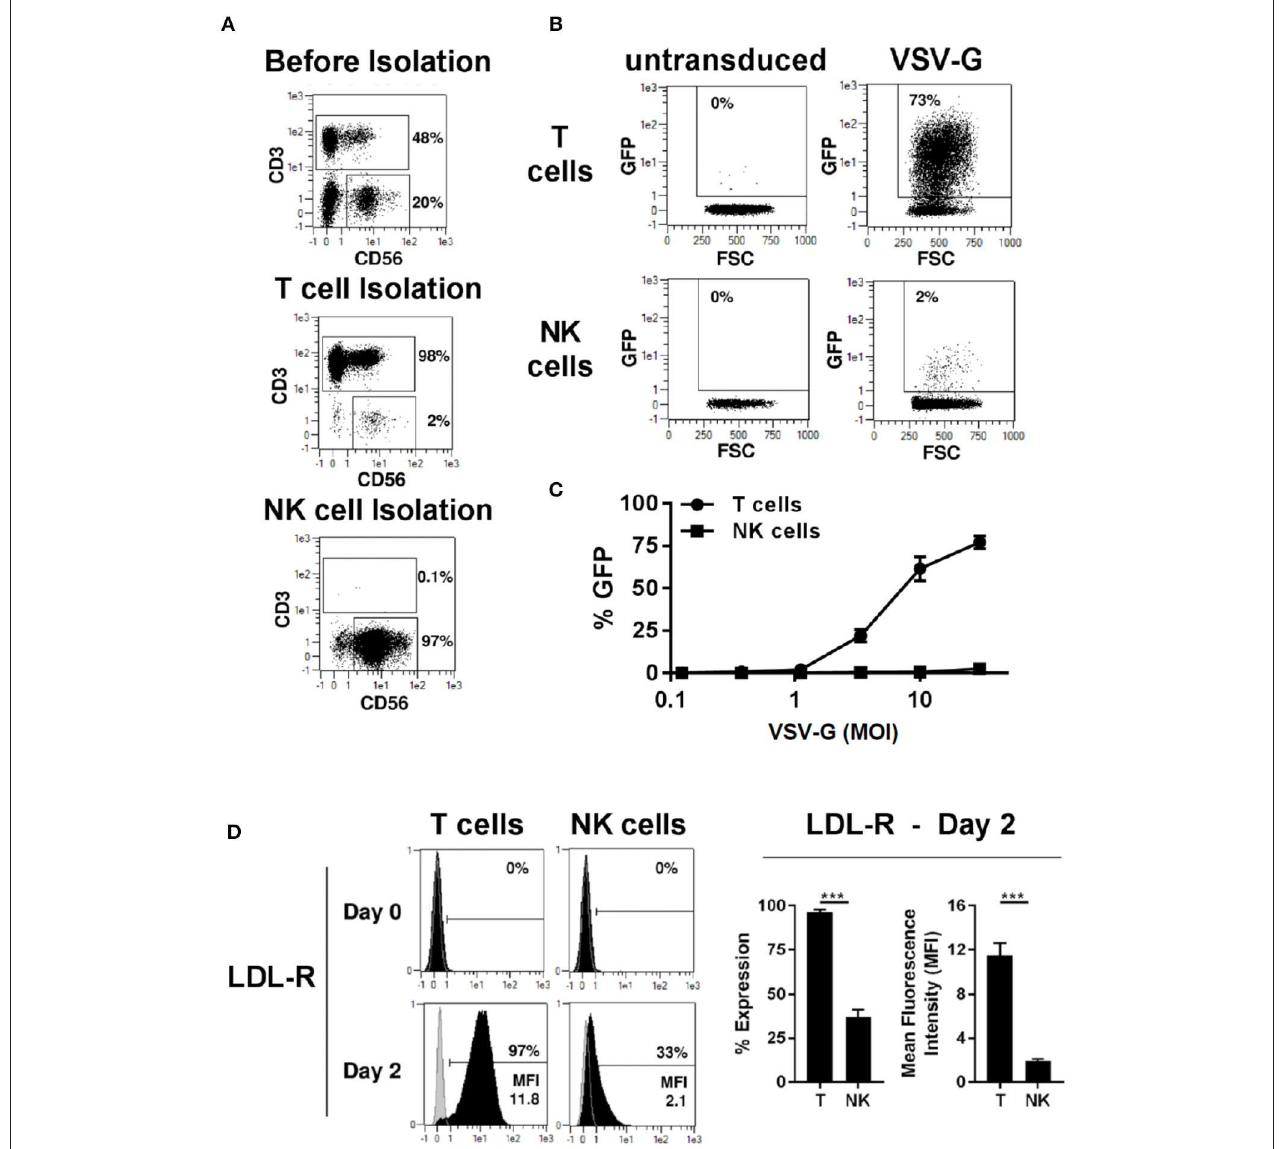
FIGURE 1 | VSV-G pseudotyped LV efficiently transduces T cells but not NK cells. Magnetic separation was used for isolation of T cells (CD3 + ) and NK cells (CD3 − /CD56 + ) from PBMC (A) . Purified T and NK cells were cultivated for 2 days, then transduced with different titers of VSV-G pseudotyped LV at MOI 10 for GFP expression or left non-transduced as a control. Exemplary dot plots from 1 donor are shown for MOI 10 (B) . NK and T -cells were transduced with different MOI (C) . The expression of VSV-G receptor LDL-R was measure at day 0 and 2 days after activation (D) . The results shown are average from at least three different donors. *** P ≤